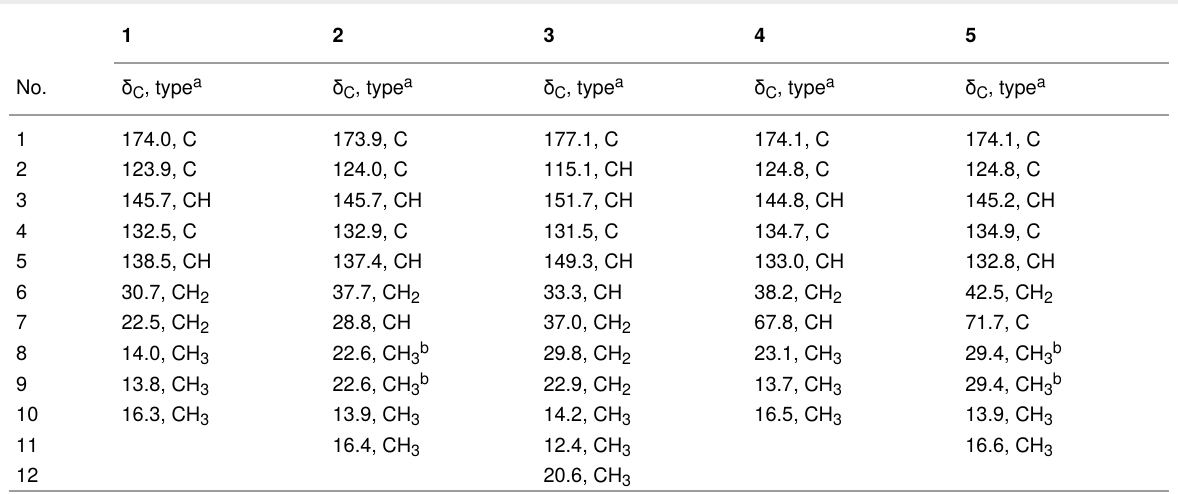
Table 1: 13 C NMR data for 1 – 5 in CDCl 3 .